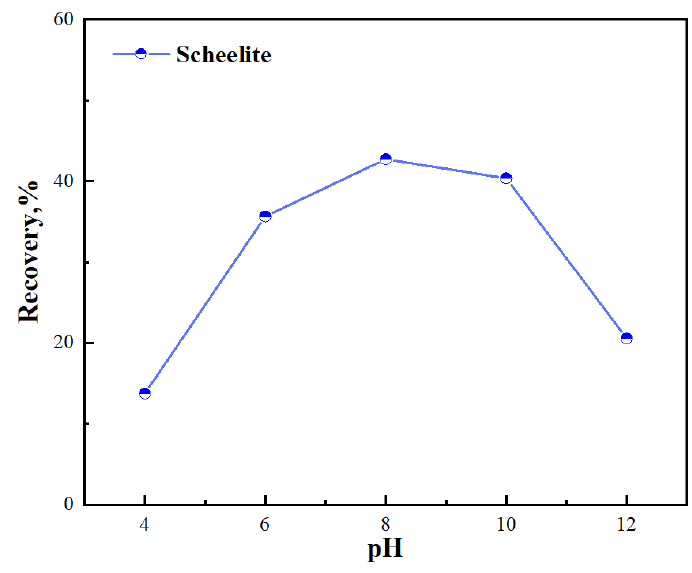
Figure 2. Effect of pulp pH on flotation recovery of scheelite in BHA system.